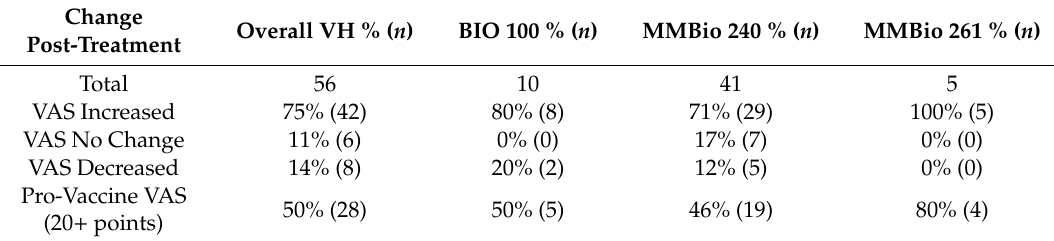
Table 3. Survey intervention and education significantly improves vaccine-hesitant student VASs. Change Post-treatment Overall VH % ( n )